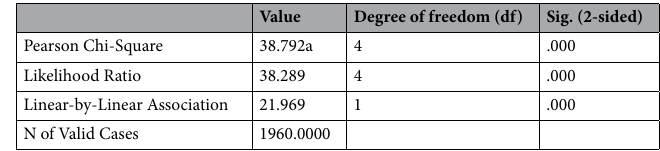
Table 1. A table showing that there was a significant difference between responses from the two different countries studied, p = 0.001.